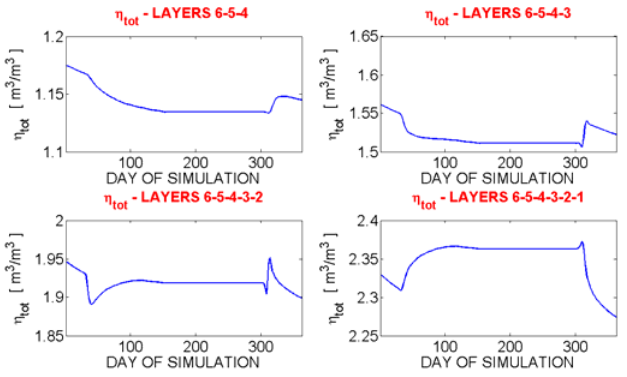
trend relative to the sensitivity test summarized in Figure 9, considering: the Figure 11. η tot three deepest soil layers (top left), the four deepest soil layers (top right), the five deepest soil layers (bottom left), and all soil layers (bottom right).